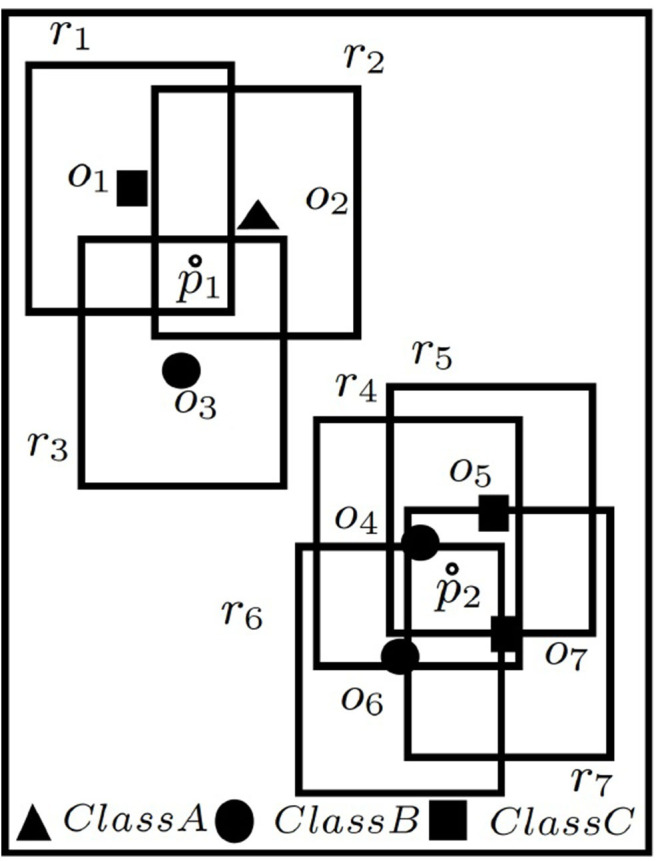
C-MaxRS → dual problem.